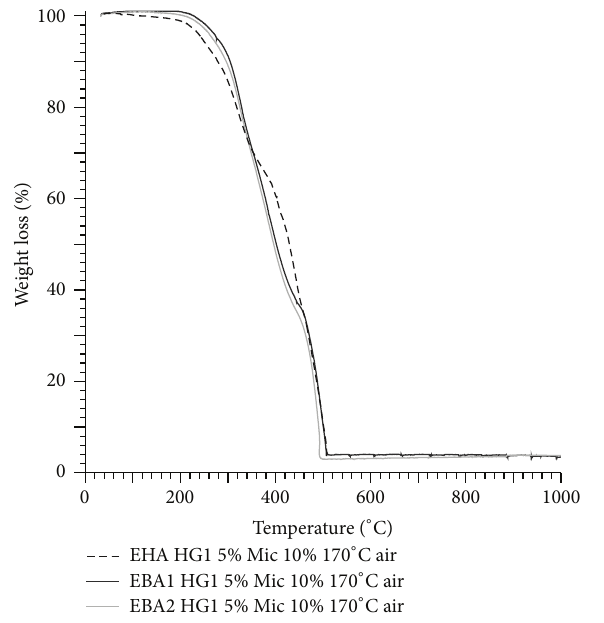
Figure 9: Thermogravimetric curves in air for self-healing systems with different epoxy matrices (EHA, EBA1, and